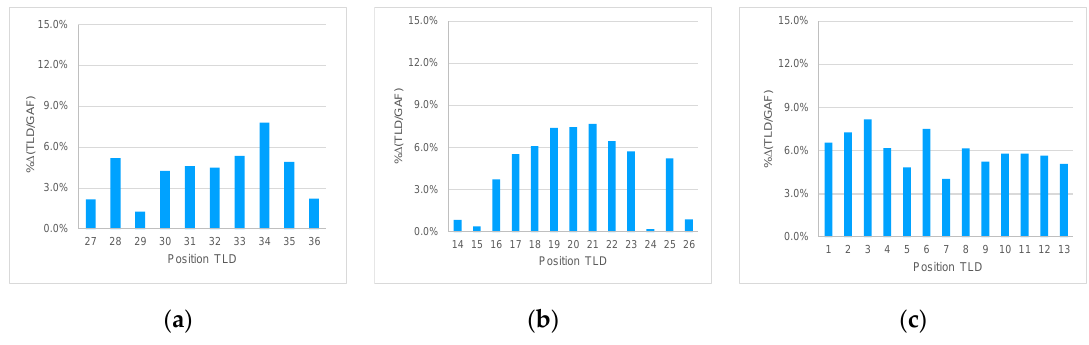
Figure 7. The difference in percentage for Gafchromic TM and TLD responses: ( a ) 17th slab; ( b ) 18th slab; ( c ) 19th slab.